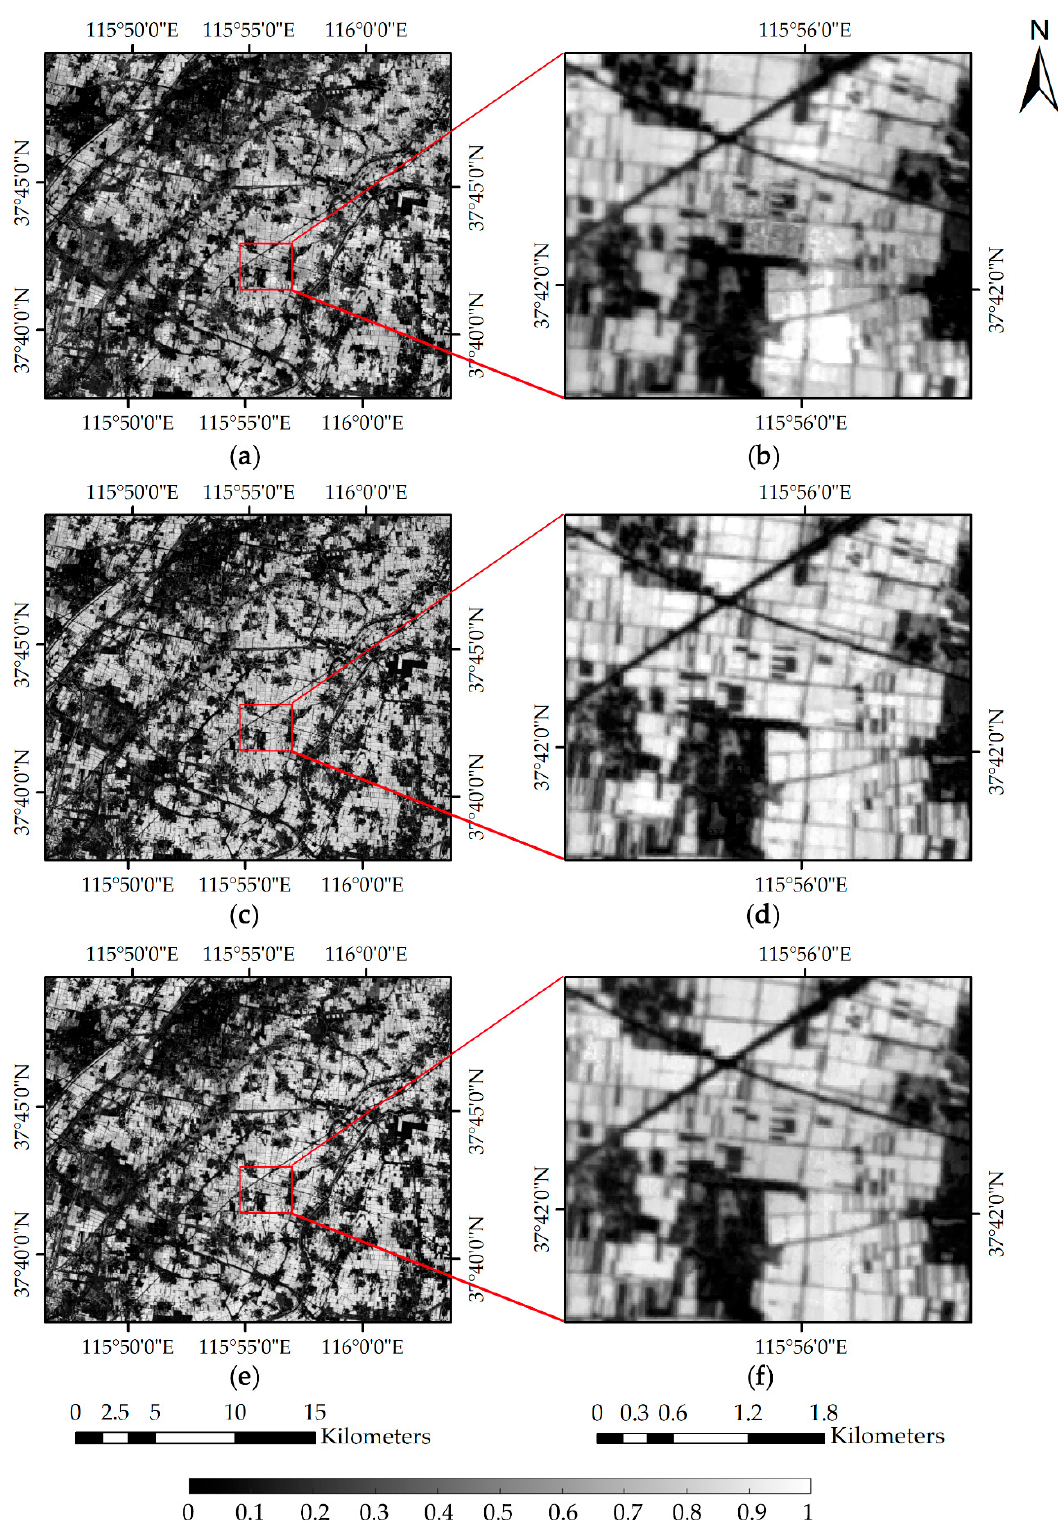
Figure 8. Actual FVC data on 26 April 2017 ( c ) and its predicted results based on the strategy of fusing reflectance data (FC) ( a ) and the strategy of fusing derived FVC (CF) ( e ). The right column images ( b , d , f ) show the details of the region marked in the left column images. The difference between the predicted and actual FVC data is represented by difference maps and difference histograms (Figure 9). Most of the pixels are concentrated between − 0.1 and 0.1, making